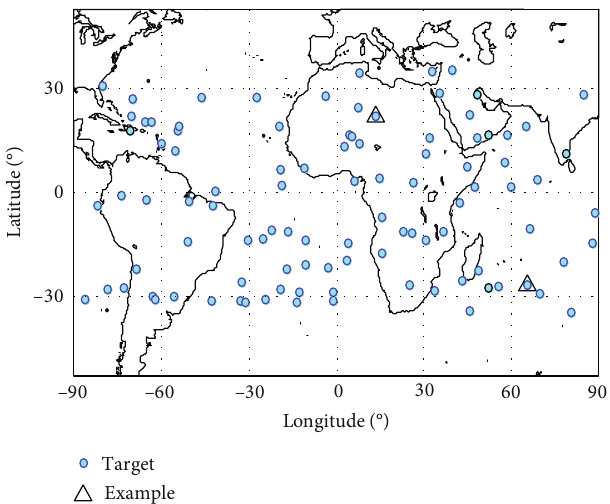
Figure 17: 100 groups of sensitive target distribution settings.